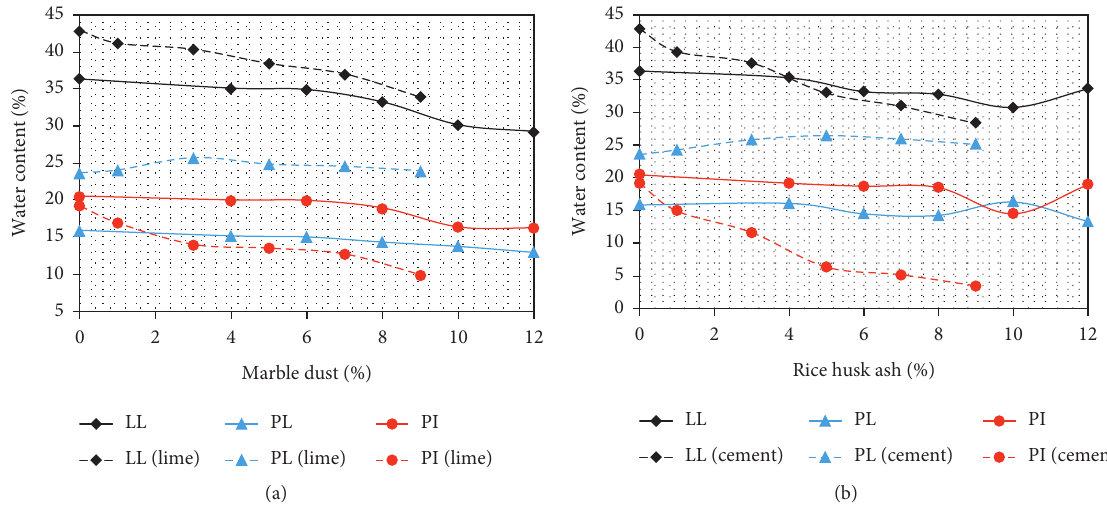
Figure 5: (a, b) Consistency limits with marble dust/rice husk ash. Note: Data of lime and cement in “a” and “b”, is taken from Sharma et al. [18] for purpose of comparison.